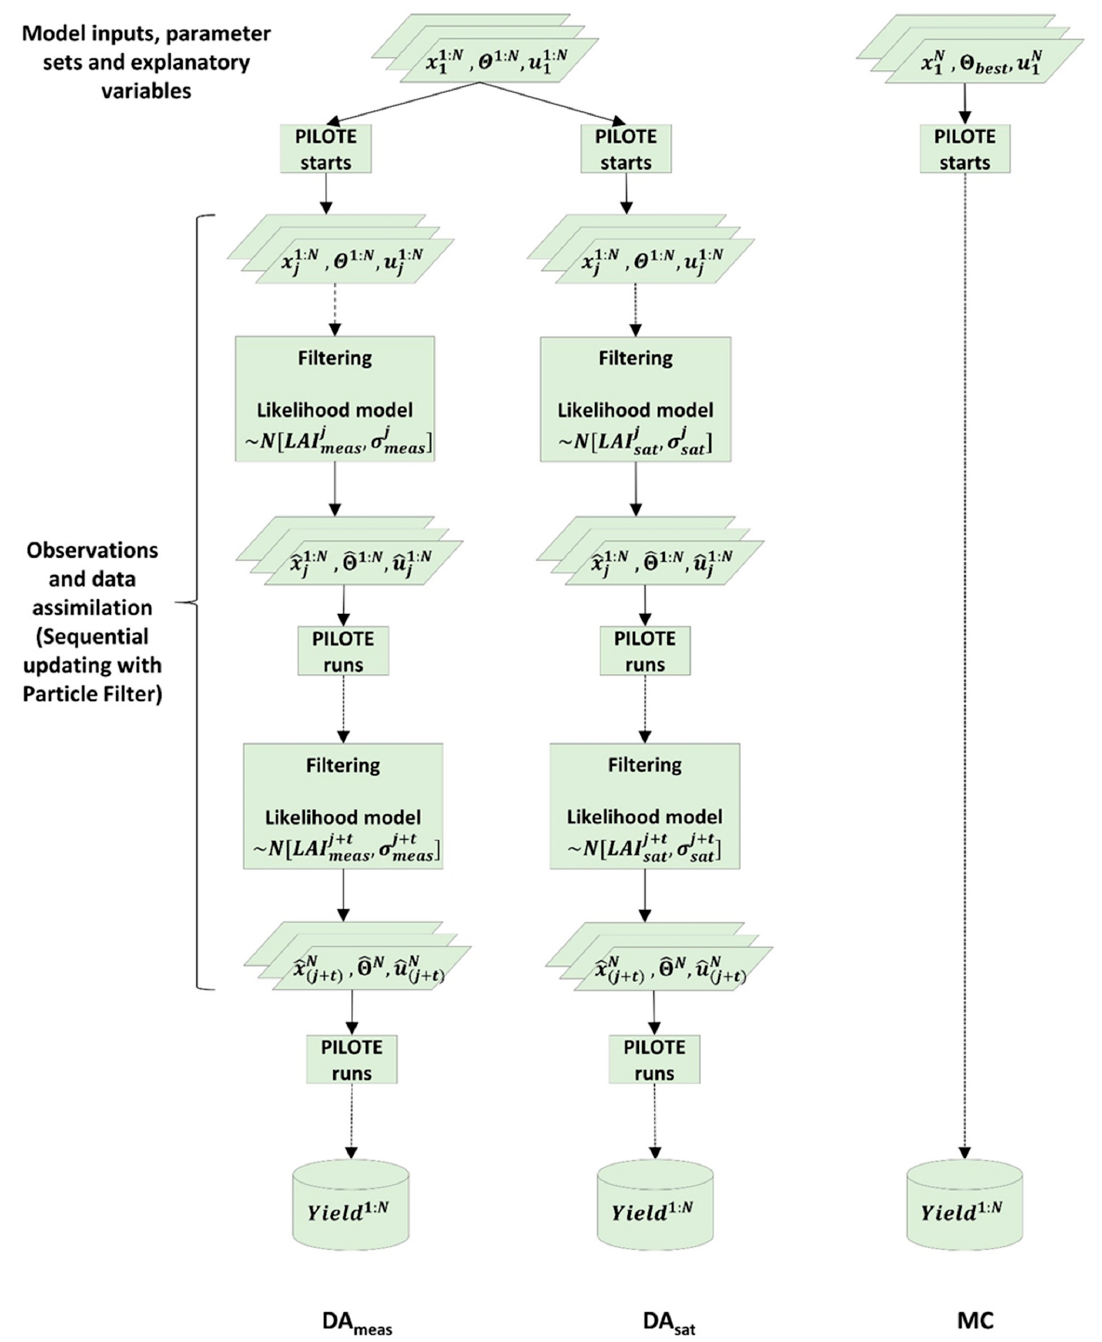
Figure 3. Yield prediction process with different methods. The two approaches on the left differ in the filtering technique applied. LAI meas and LAI sat are measured and remotely-sensed LAI, respectively with σ obs and σ sat represent the corresponding standard deviations. The symbols x , Θ , u and N represent state variables, parameter vector, explanatory variables (initial conditions and forcing data), and the number of particles. ˆ x , ˆ Θ and ˆ u are the corresponding filter-updated counterparts. (cid:104) (cid:105) ∼ N LAI j meas , σ j stands for the normal distribution with mean LAI j and standard deviation obs meas / sat σ j . The sequential updating continues until the last observation is available. DA meas stands for meas / sat data assimilation based on LAI data measured in-situ, DA sat for data assimilation based on LAI from satellite observations and MC for Monte-Carlo simlations as baseline to test the performance of the data assimilation